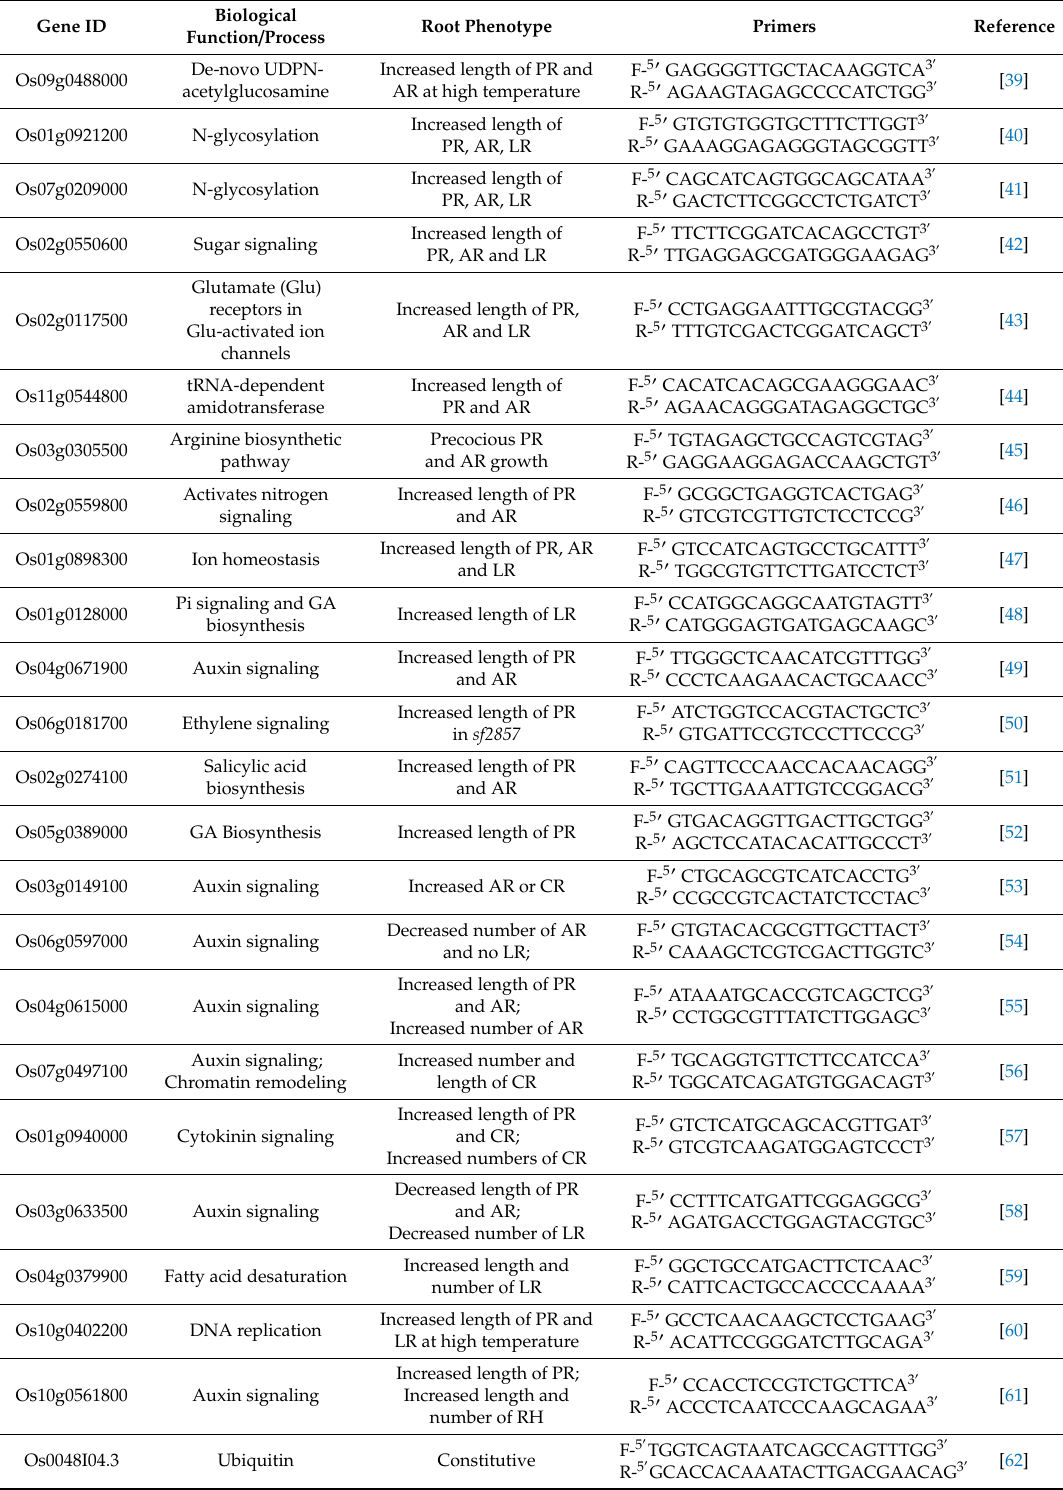
Table A1. Identified genes that control root growth and development in